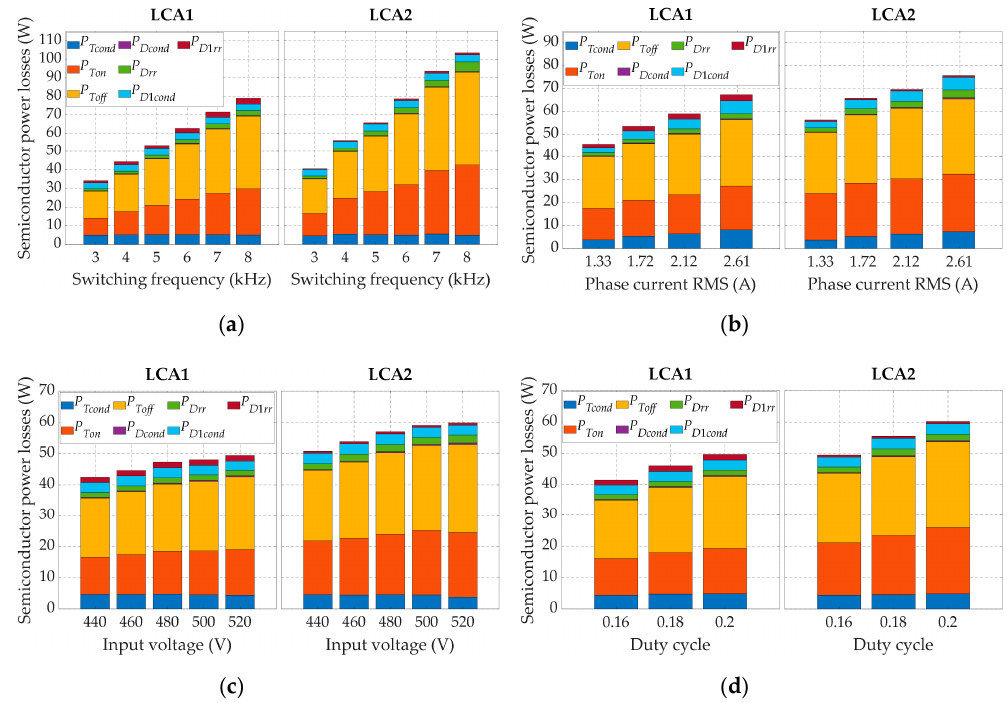
Figure 7. Semiconductor power losses distribution with respect to: switching frequency ( a ), RMS phase current ( b ), input voltage ( c ), and duty cycle ( d ).